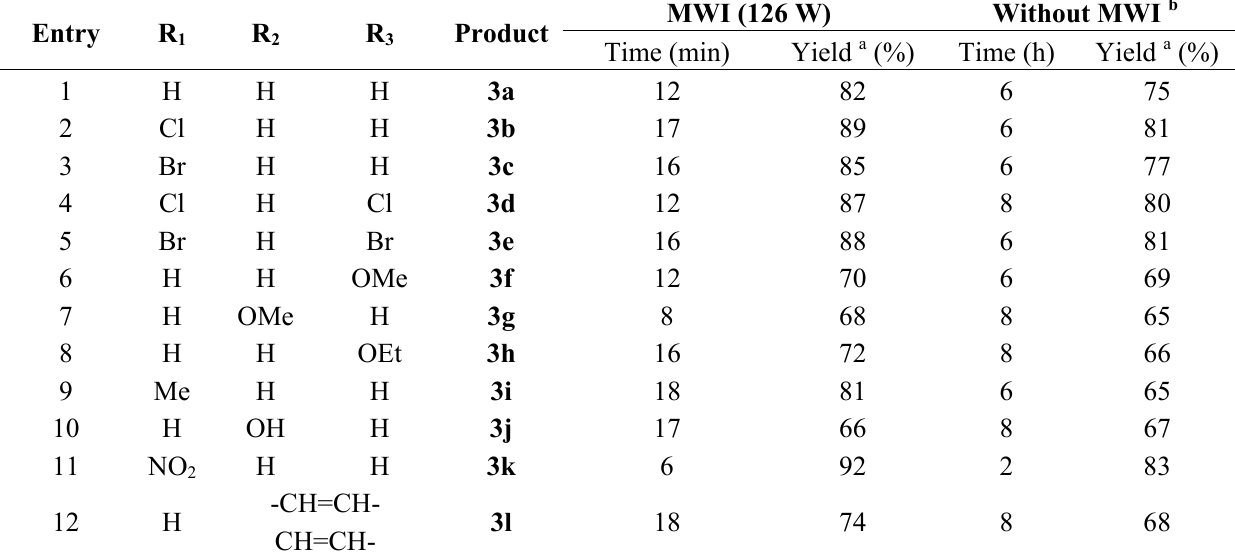
Table 2. Synthesis of 2-hydroxy-2-(trifluoromethyl)-2 H -chromenes 3a – l under optimum conditions.